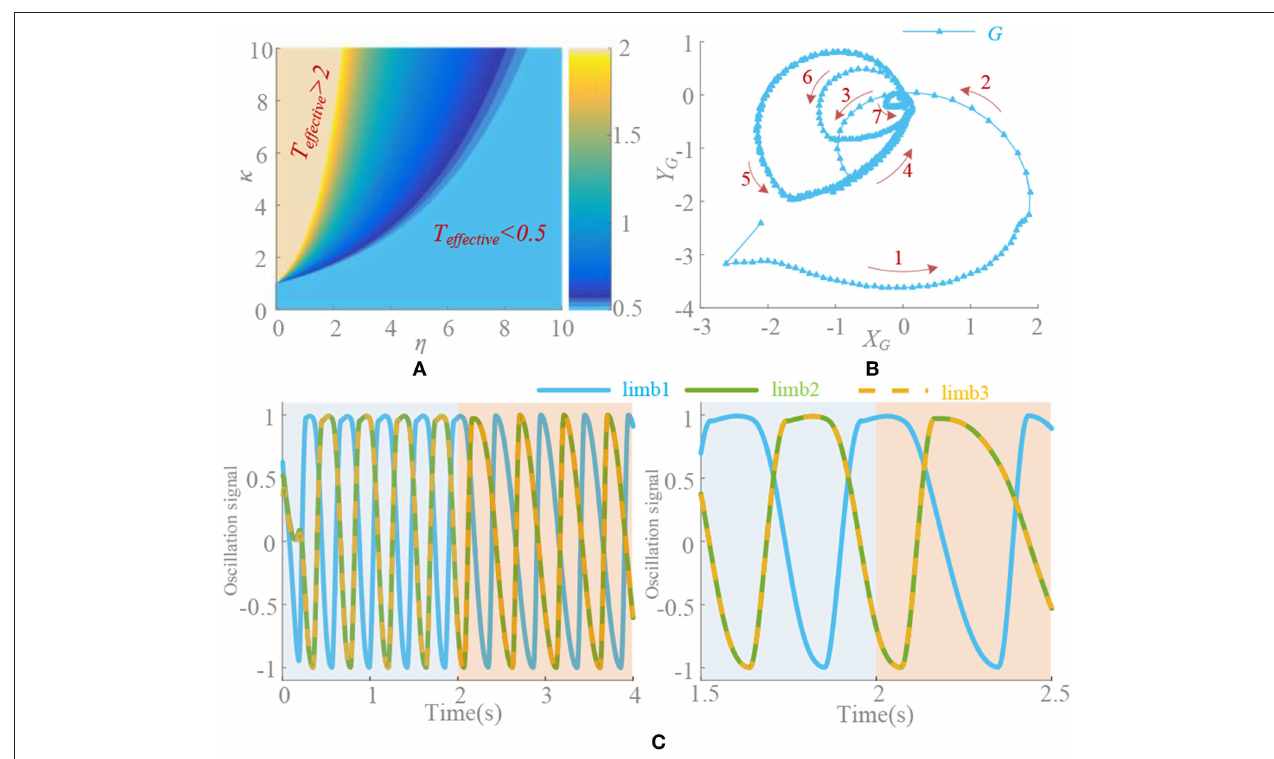
FIGURE 6 | (A) Effective time surface of k e (t). T effective > 2s and T effective < 0.5s is marked. T = 0.5s. (B) Convergence process. Red arrow is the direction of limit circle. (C) Deformation elimination. k (t) = 5 in 0–2s and changes to k e (t) at 2s ( t 0 = 2s). ρ = 5/6, κ = η = 5, t 0 = 2s, ψ = [0, 0.5, 0.5, 0, 0, 0.5] and signal of limb 1, 2, and 3 are